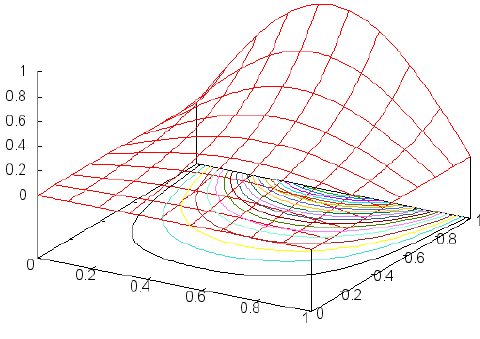
Figure 5. Exact solution of the problem